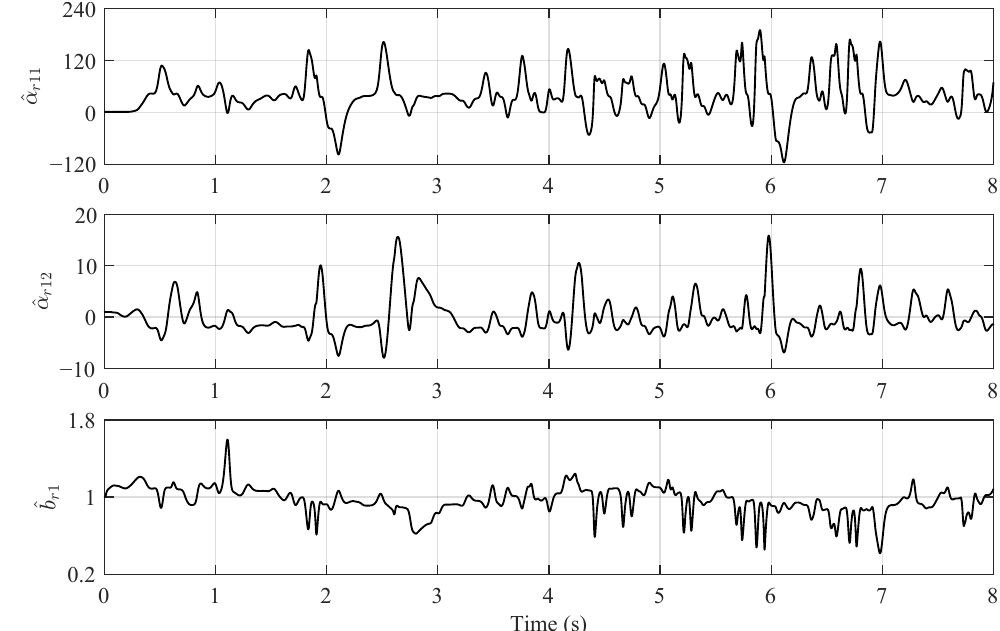
Figure 3. Estimations of the reformed plant 1’s